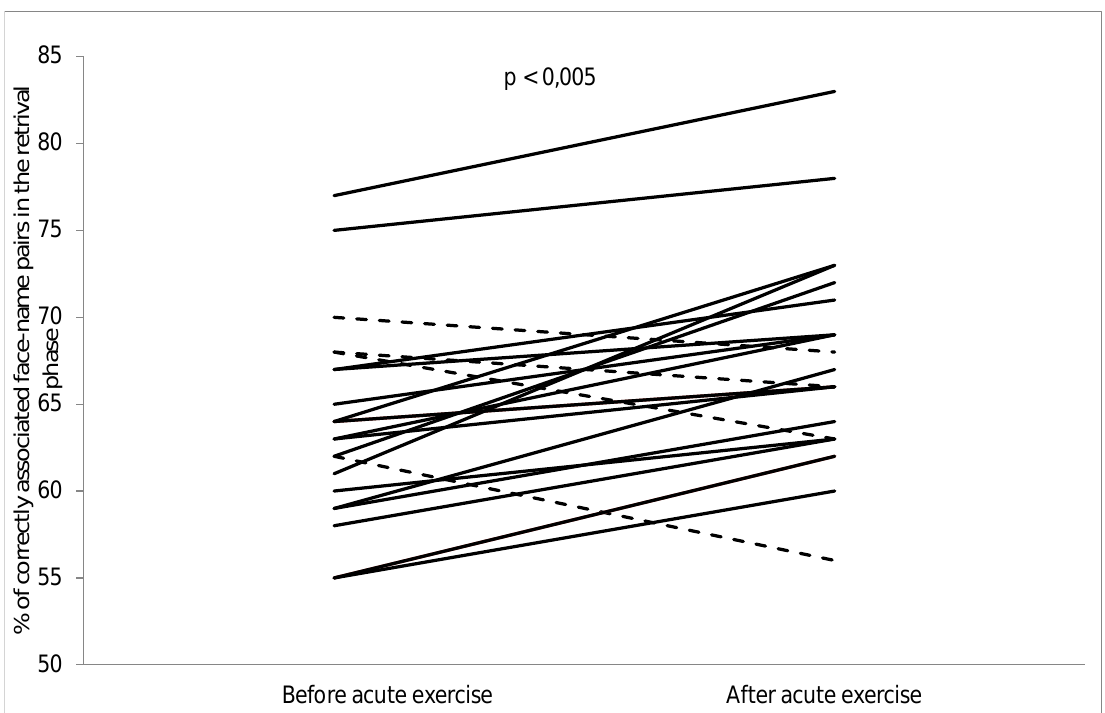
Fig.1. Individual scores in the face/name association test - % correctly associated face-name pairs. Each subject’s results from before and after acute exercise are connected by a line. Solid line depicts subjects who fared better on the post-exercise test, dashed lines those who fared worse after acute physical exercise.